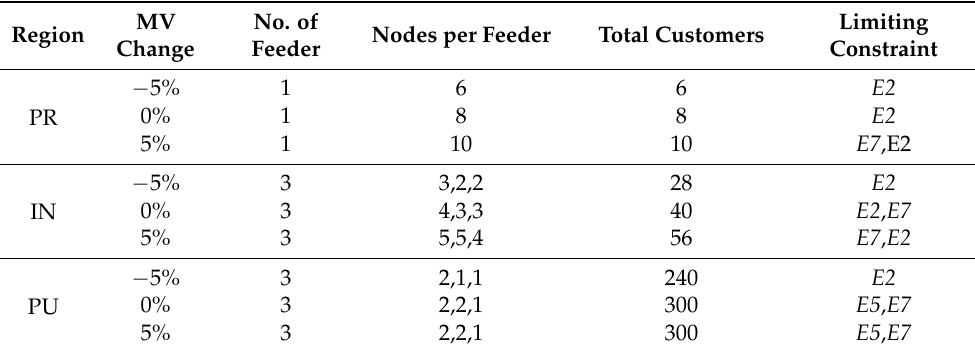
Table 4. Test network parameters and their limiting constraints for domestic customers.